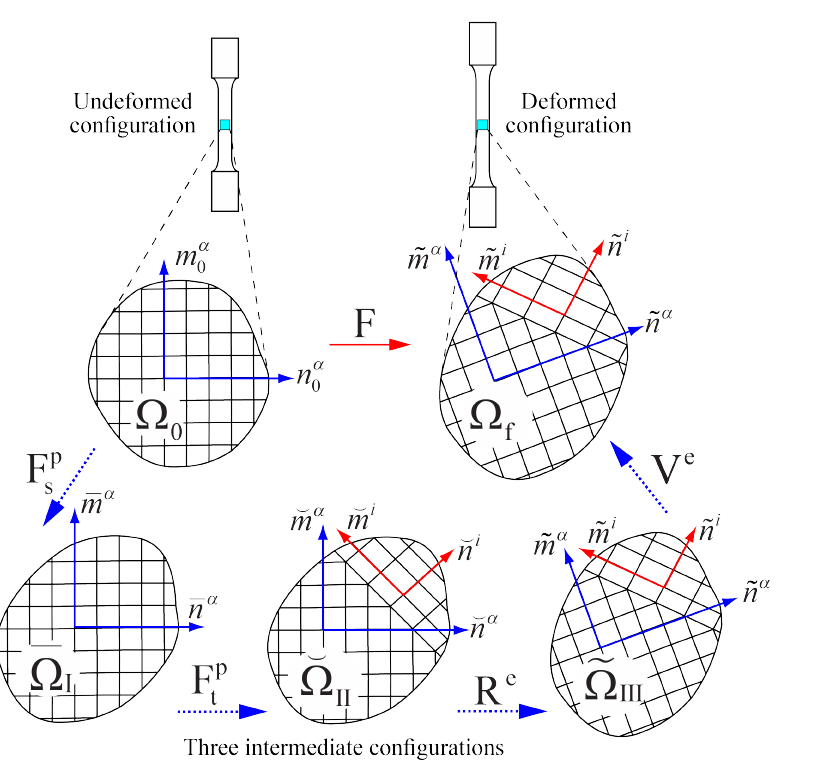
Figure 1. Kinematic decomposition of a material point into three intermediate configurations: ¯ Ω I , ˘ Ω ˜ Ω II , and III